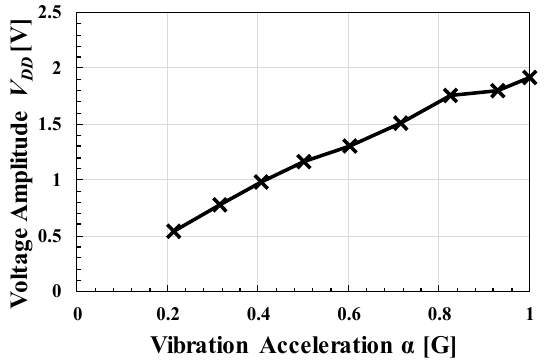
Figure 20. Measured V DD as a function of α ( R L = ∞ , f IN = 195 Hz).